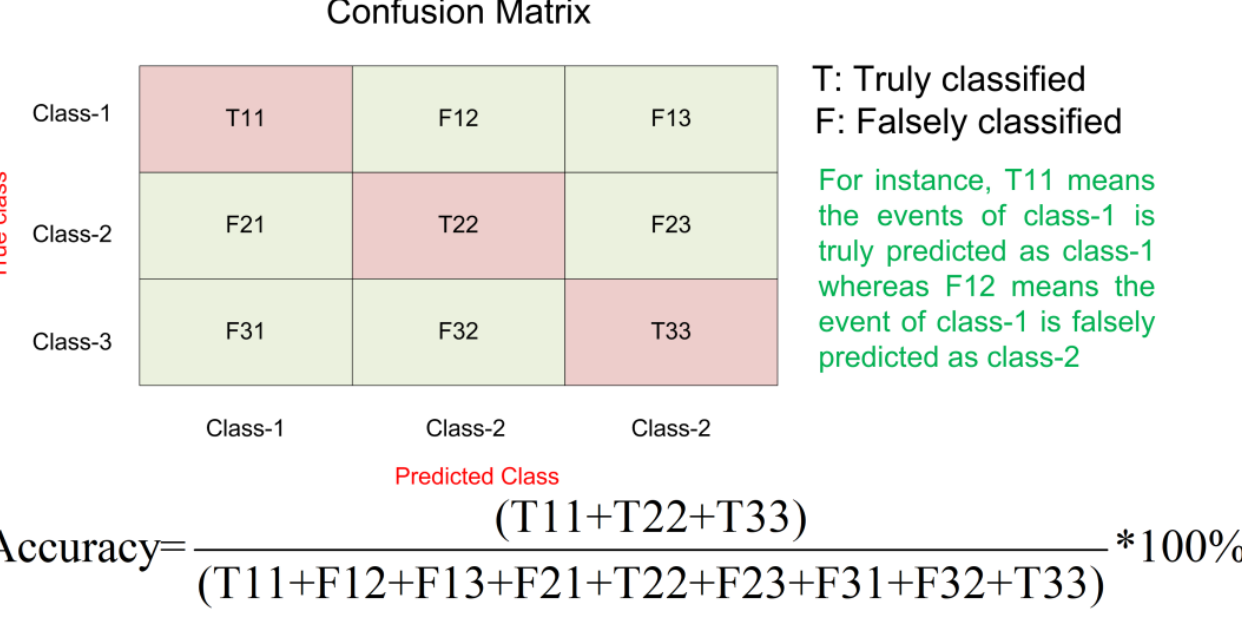
Figure 4. Pictorial representation of confusion matrix and mathematical formulation of accuracy.